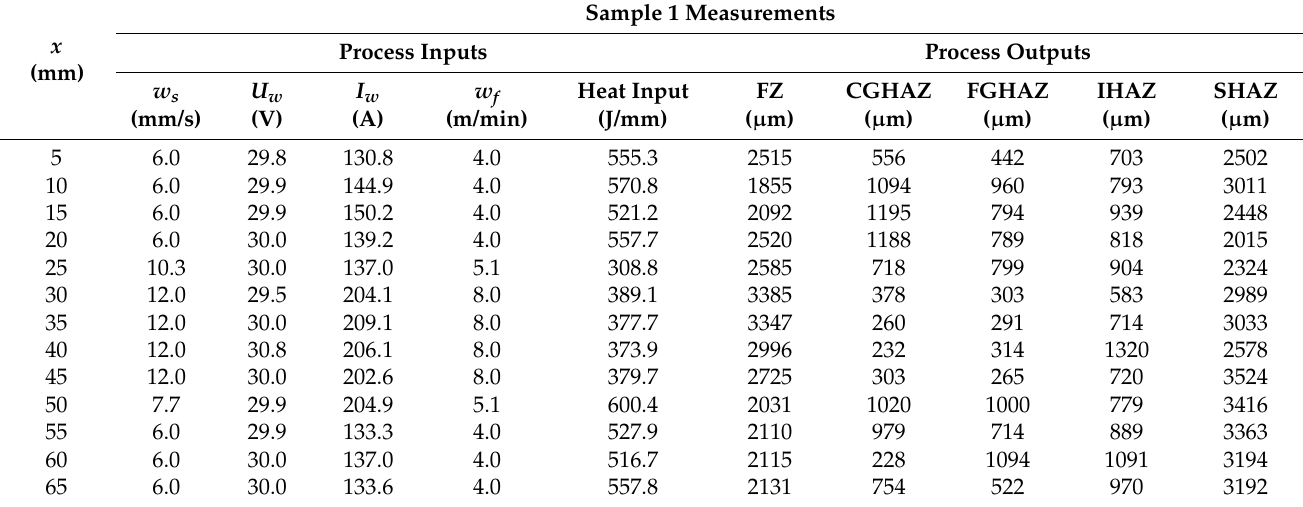
Table 4. Measurements corresponding to sample 1.